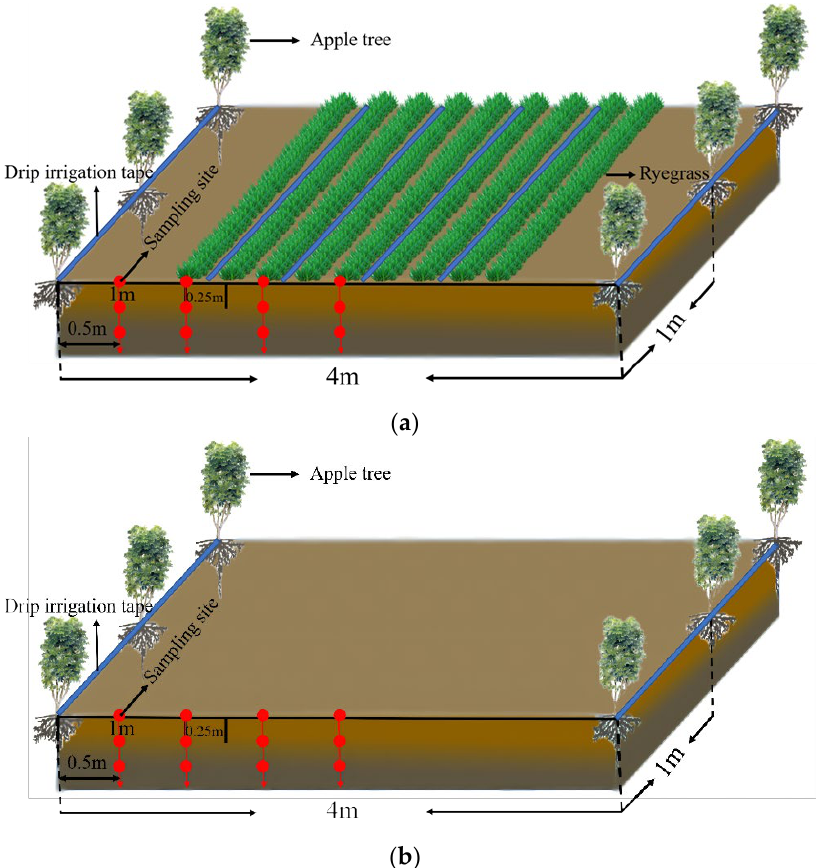
Figure 1. ( a ): diagram of apple and ryegrass planting in an apple/ryegrass intercropping system; ( b ): diagram of apple growing in an apple monoculture system.